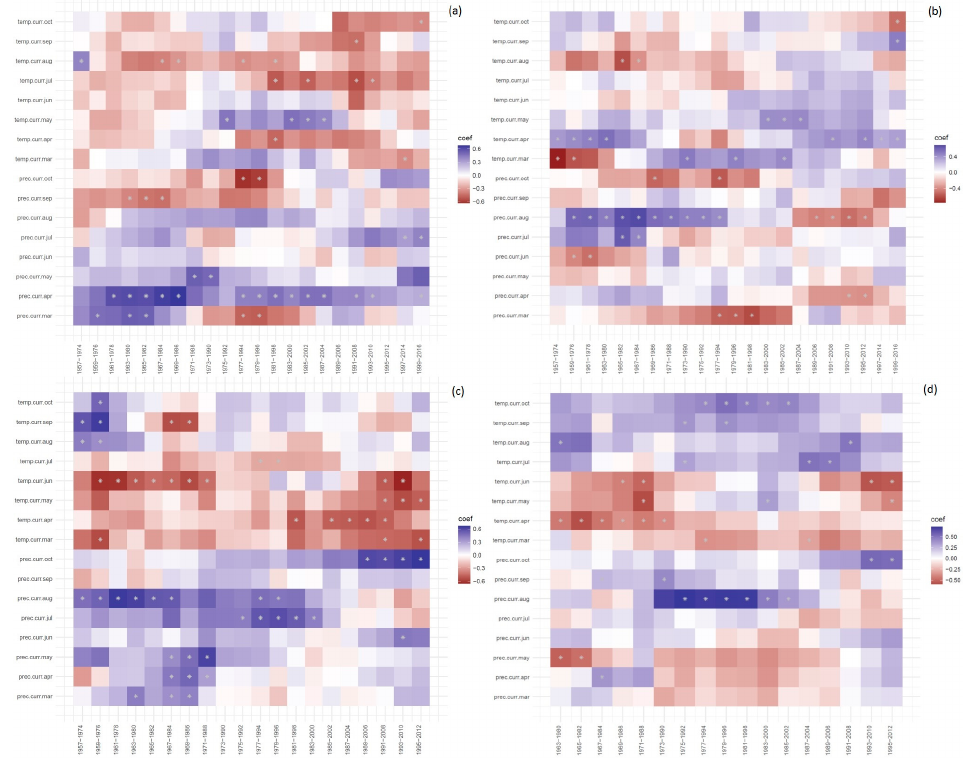
Figure 8. Plot of moving correlation function relating ( a ) TRW chronology of Ili ( b ) δ 13 C series of Ili ( c ) TRW chronology of Manas ( d ) δ 13 C series of Manas to temperature and precipitation of current March to current October. The moving correlation is carried out in windows of 18 a, offset by 2 a. Asterisks (*) indicate significant correlations ( p < 0.05).